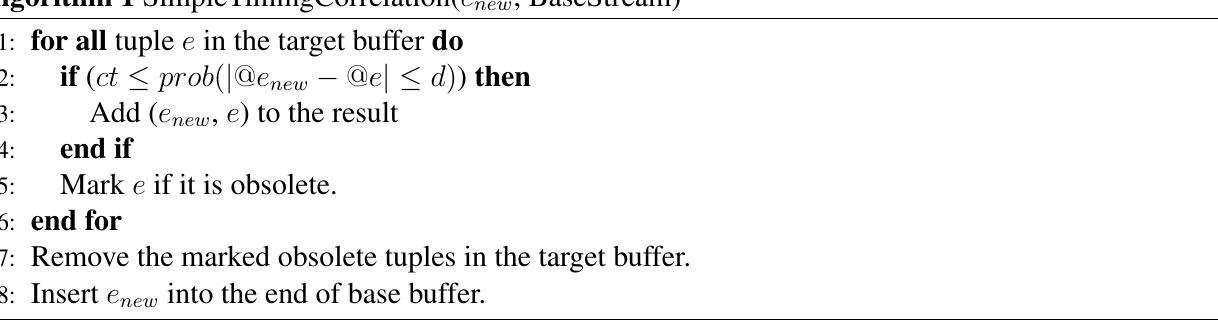
Algorithm 1 SimpleTimingCorrelation( e